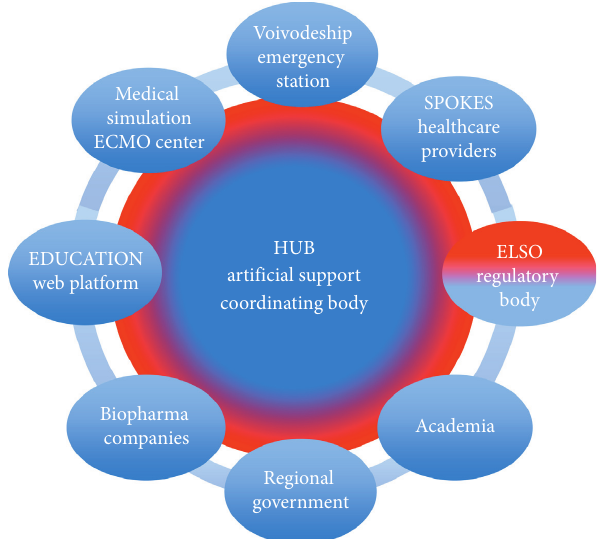
Figure 4: “ECMO for Greater Poland” Innovation